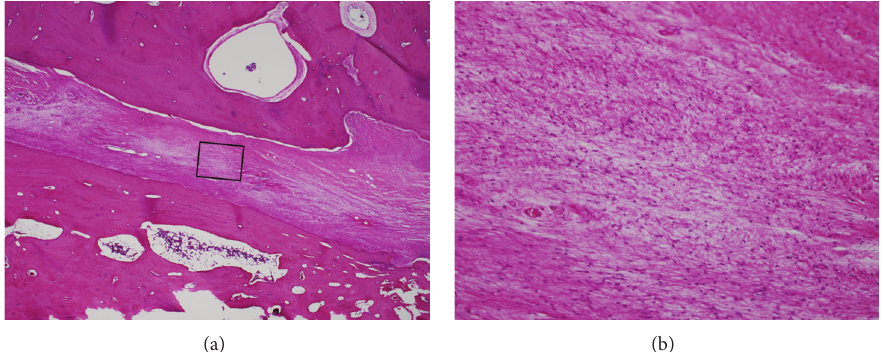
Figure 4: Histopathological findings of resected specimens. (a) Neurofibroma of the facial nerve in the mastoid segment of the osseous canal (Haematoxylin and Eosin stain; original magnification × 20). (b) Photomicrograph at higher power showing that the tumor is composed of cells with thin, elongated nuclei and scant cytoplasm, embedded in a myxoid stroma. Note that there is no evidence of malignancy (Haematoxylin and Eosin stain; original magnification ×